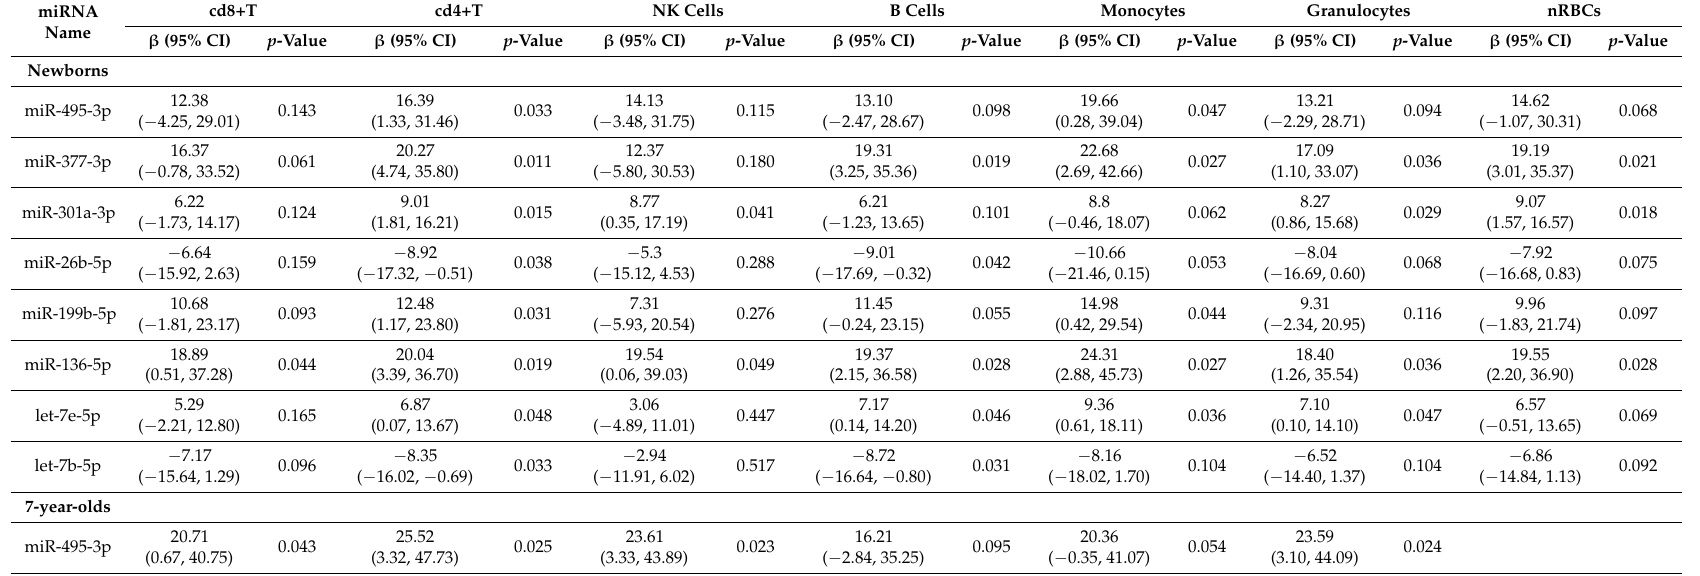
Table 3. Associations of blood cell composition with newborn and 7-year-old miRNA